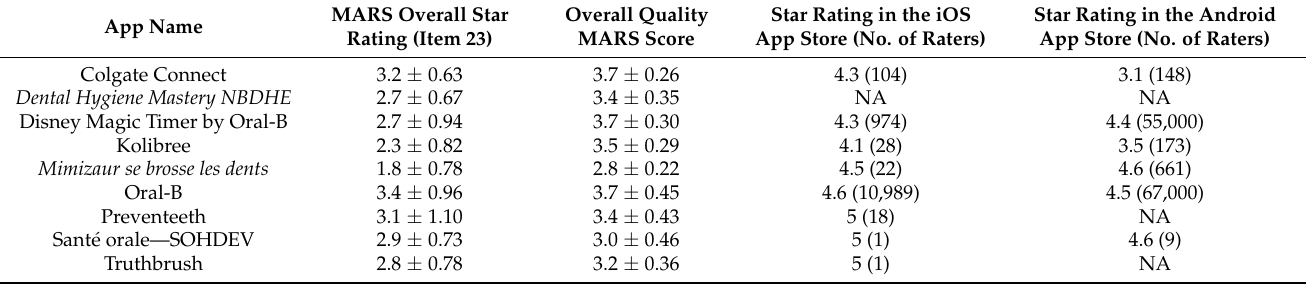
Table 3. MARS overall star rating, overall quality MARS score, star rating in the iOS App Store, and star rating in the Android app store of the nine oral-hygiene-related mobile